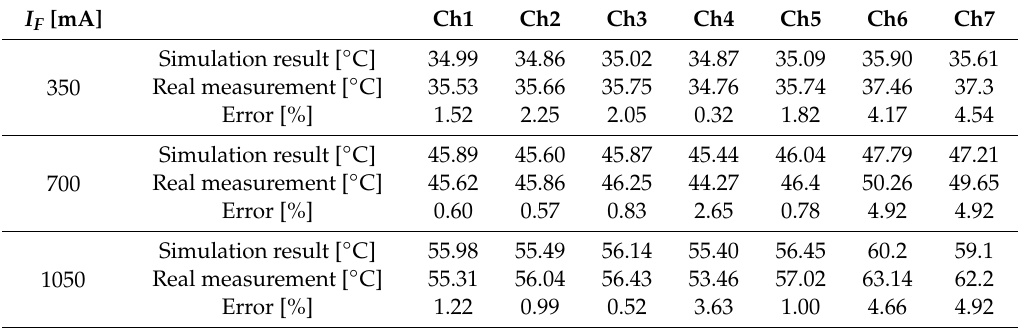
Table 3. Comparison of temperature simulation results and real measurements in seven measuring points.